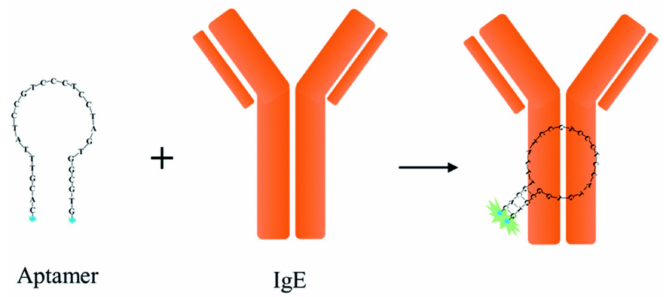
Figure 8. Schematic representation for the detection of IgE [36].